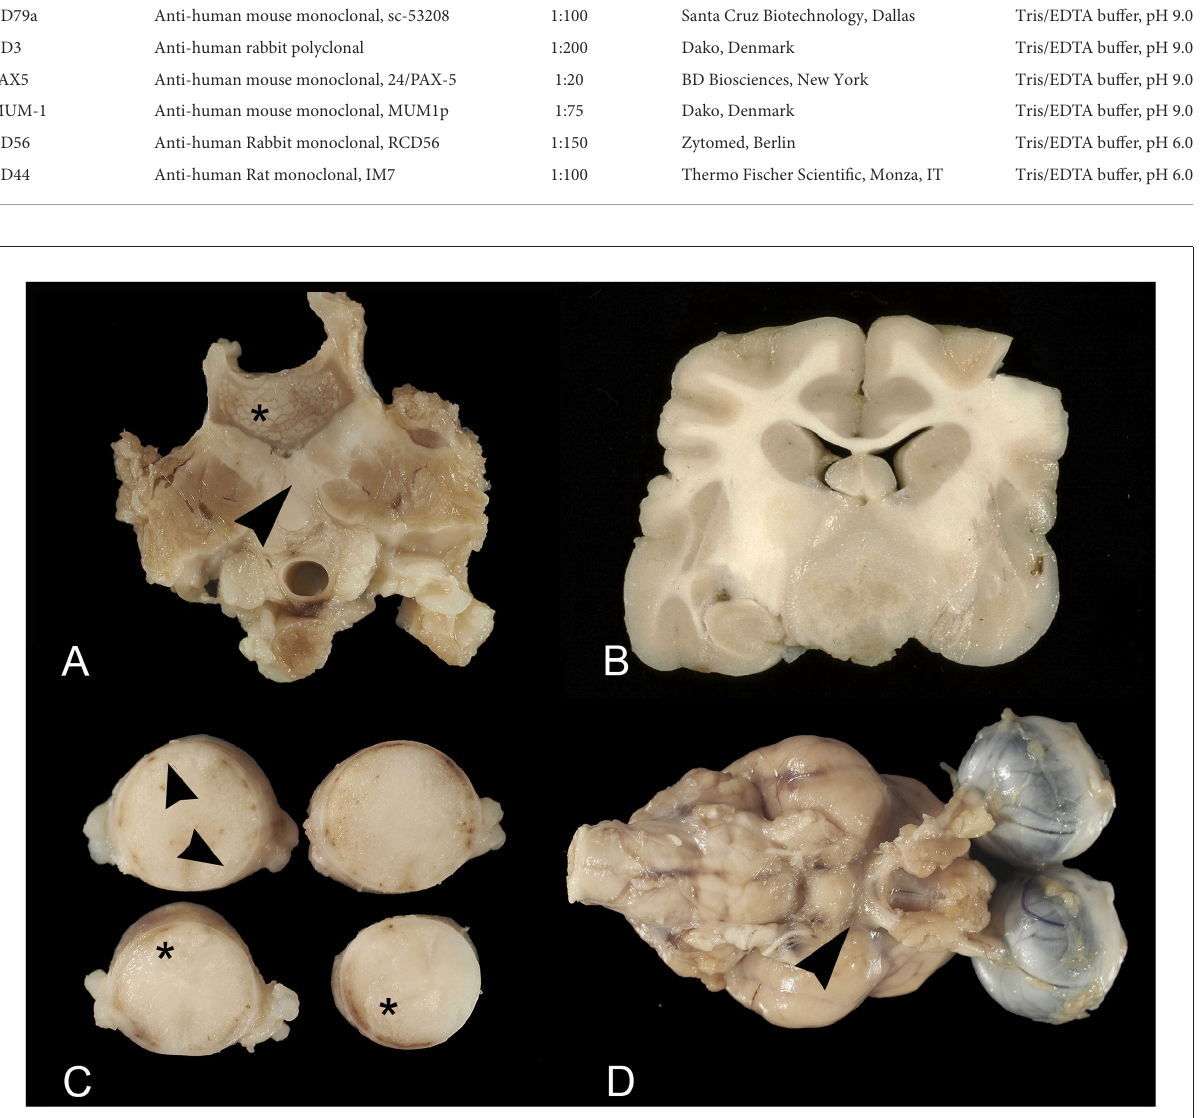
PAX5, MUM1, and in Tris-EDTA buffer solution (10 mmol/L Tris Base, 1 mmol/L EDTA, ph 6.0) for antibodies anti-CD44 and CD56. No retrieval was performed for the anti-CD20 antibody. Endogenous peroxidase was blocked using 3% hydrogen peroxide in water for 10 min at room